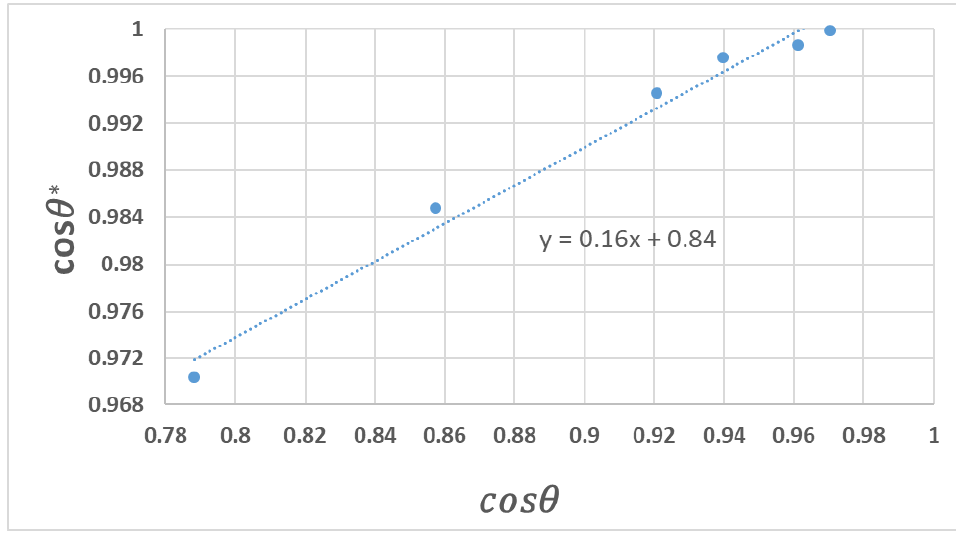
Figure 8. Plot of cos 𝜃 ∗ vs. 𝑐𝑜𝑠𝜃 .